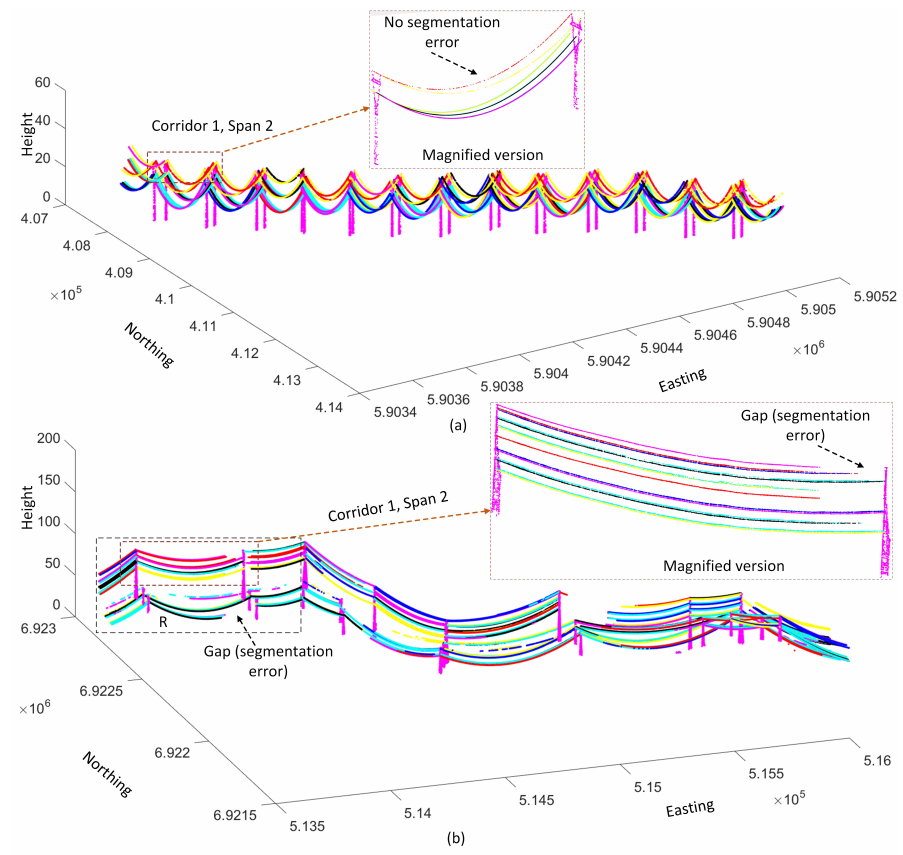
Figure 17. Extracted pylons and wires in two test datasets ( a ) Maindample; and ( b ) Bindebango. Table 4. Object-based evaluation on the whole datasets (all values are in percentage). Corridors Pylons Data Sets